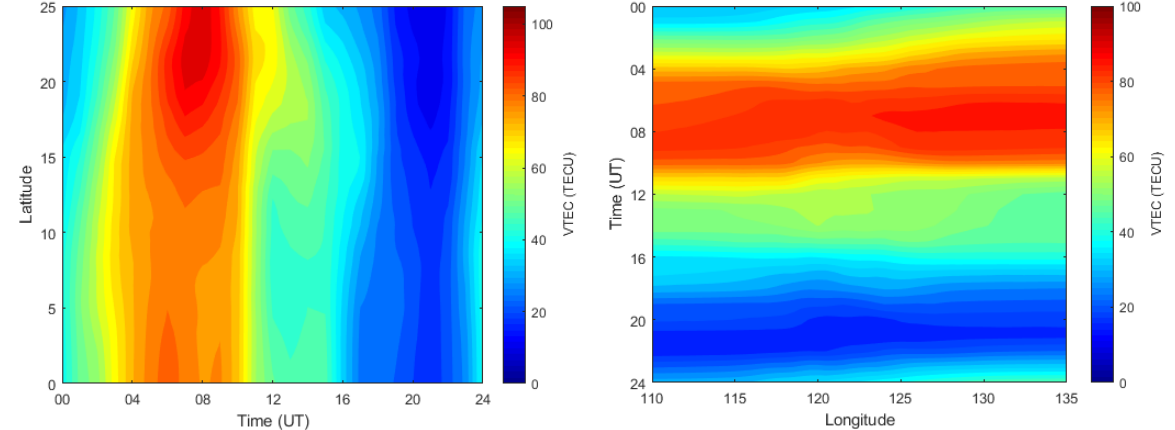
Figure 12. Latitude and longitude profiles of the average quiet day VTEC.